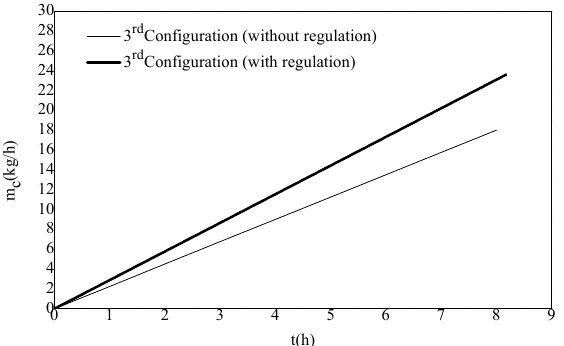
Figure 12. Variation in water temperatures.